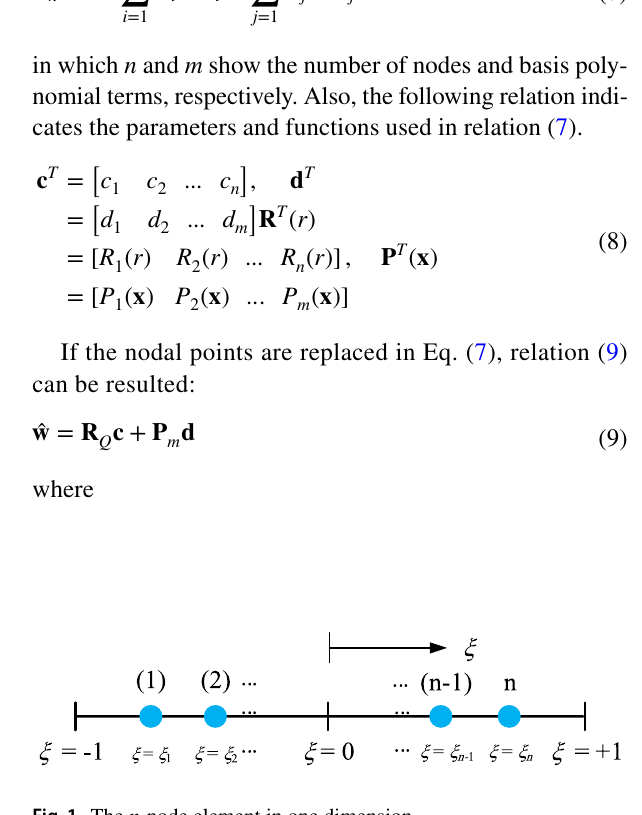
Fig. 1 The n -node element in one